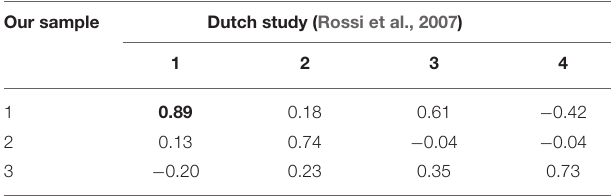
TABLE 8 | Coefficients of congruence ( 8 ) between factors of our sample and factors based on linearly dependent scales of Italian study. Our sample